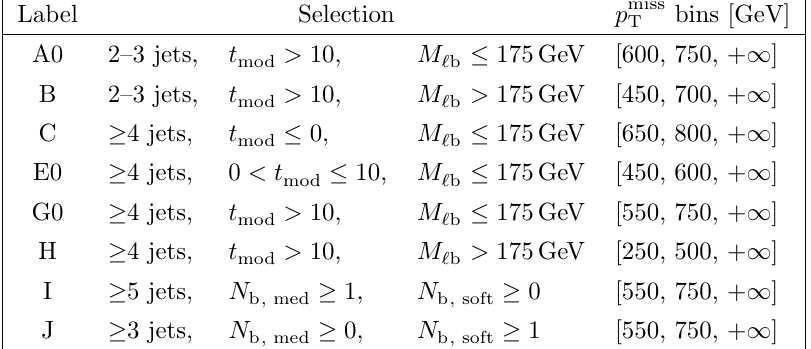
Table 4 . Dilepton control samples that are combined when estimating the lost-lepton